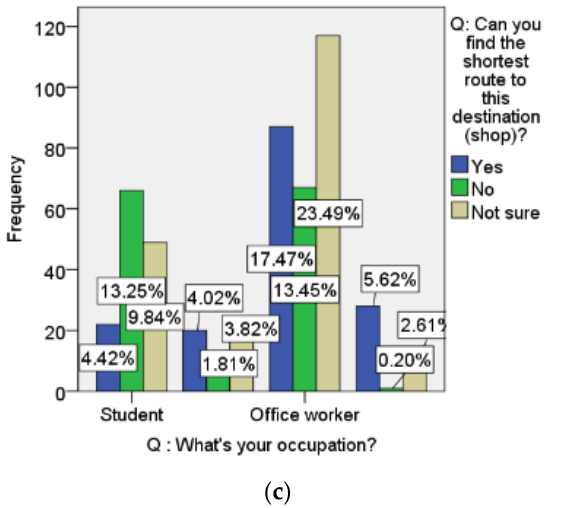
Figure 13. Frequency comparison between “Occupation” and personal data related to shopping behavior. ( a ) Shopping mall frequency; ( b ) Be familiar with the indoor map of shopping mall; ( c ) Whether the shortest path can be found.